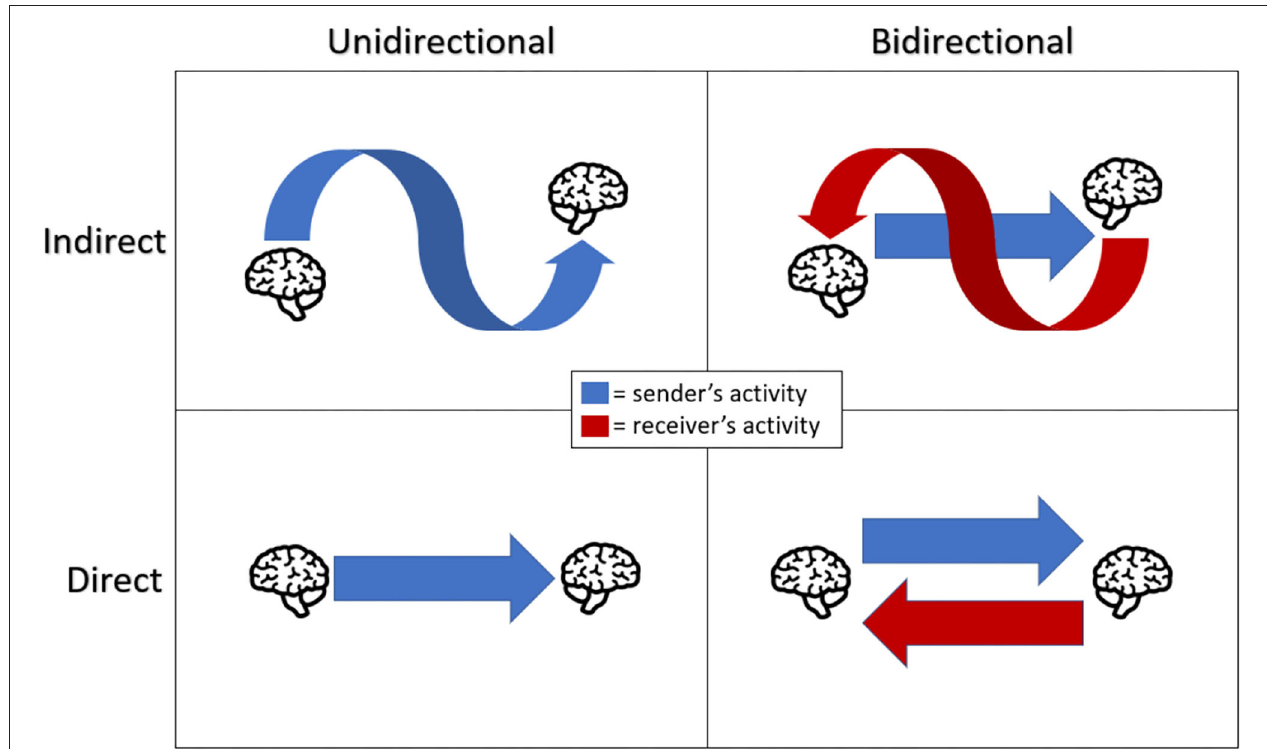
FIGURE 2 | A graphical scheme of collaboration type. Directionality refers to the flow of information, either just from sender to receiver or in both directions. Directness refers to the use of brain stimulation to send information (a straight arrow) or other means (a curved arrow). It is important to note that indirect unidirectional systems do not qualify as B2Bs by our definition and that indirect bidirectional systems could involve indirect (curved arrow) information transmission from the sender or the receiver, not just as